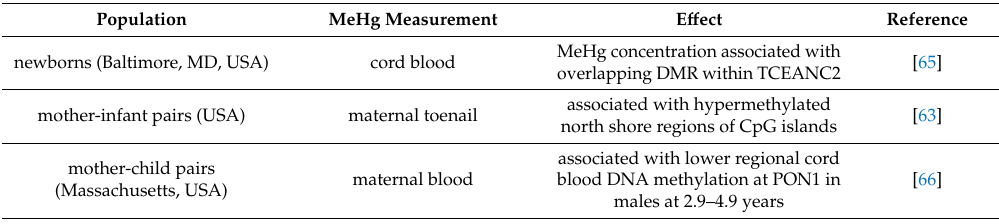
Table 4. Methylmercury e ff ects on DNA methylation in human